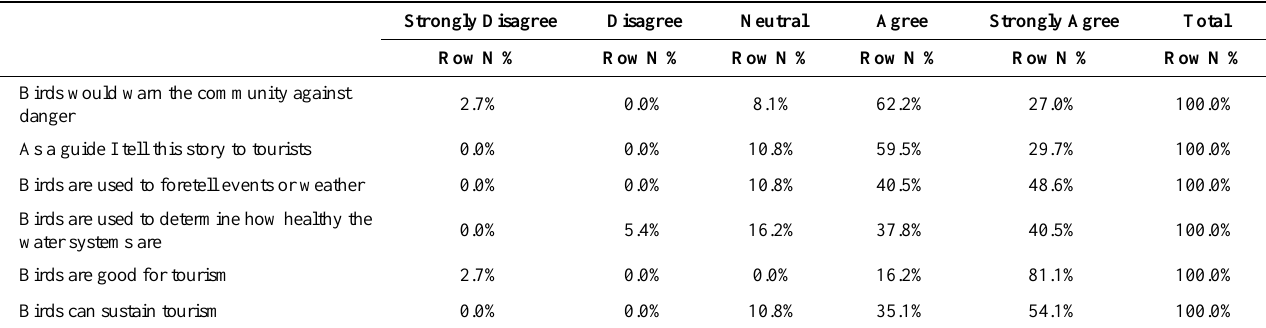
Table 3. Birds and avitourism activity